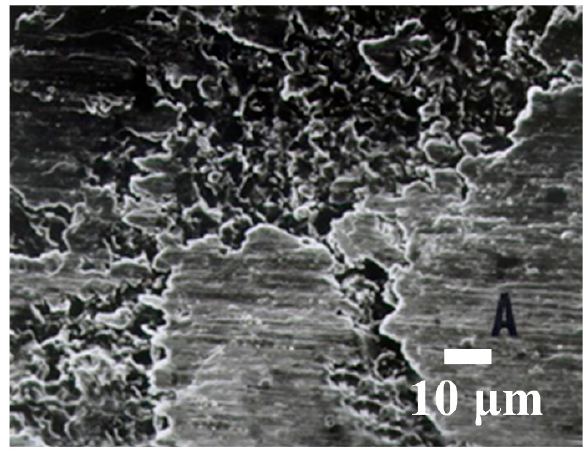
Figure 14. SEM photo of Al 2 O 3 that is machined using no slurry.